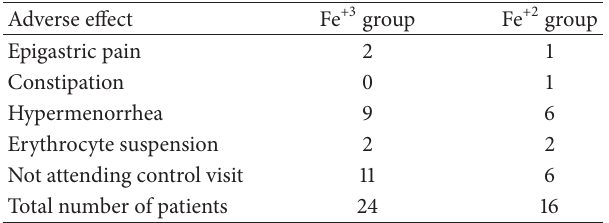
Table 1: Total 40 patients were excluded in agreement with above- mentioned